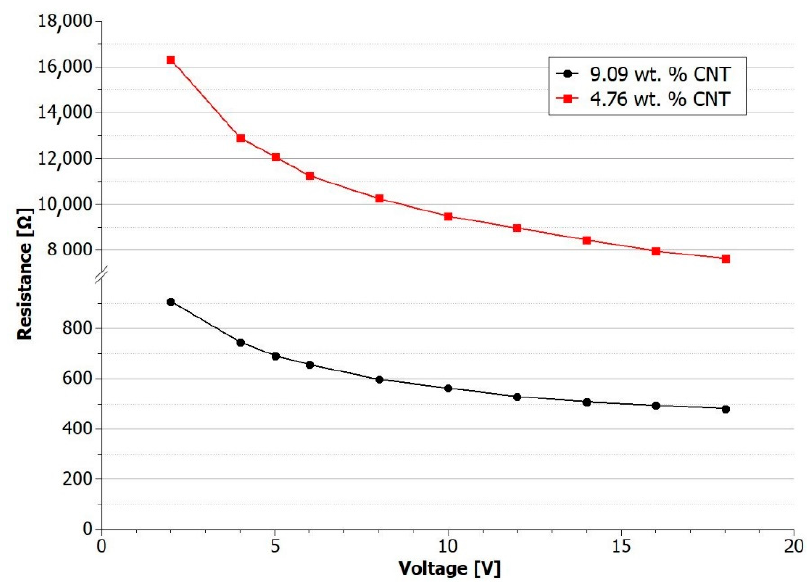
Figure 8. Electrical resistance values of conductive composite samples under different values of voltage applied for I–V measurements.